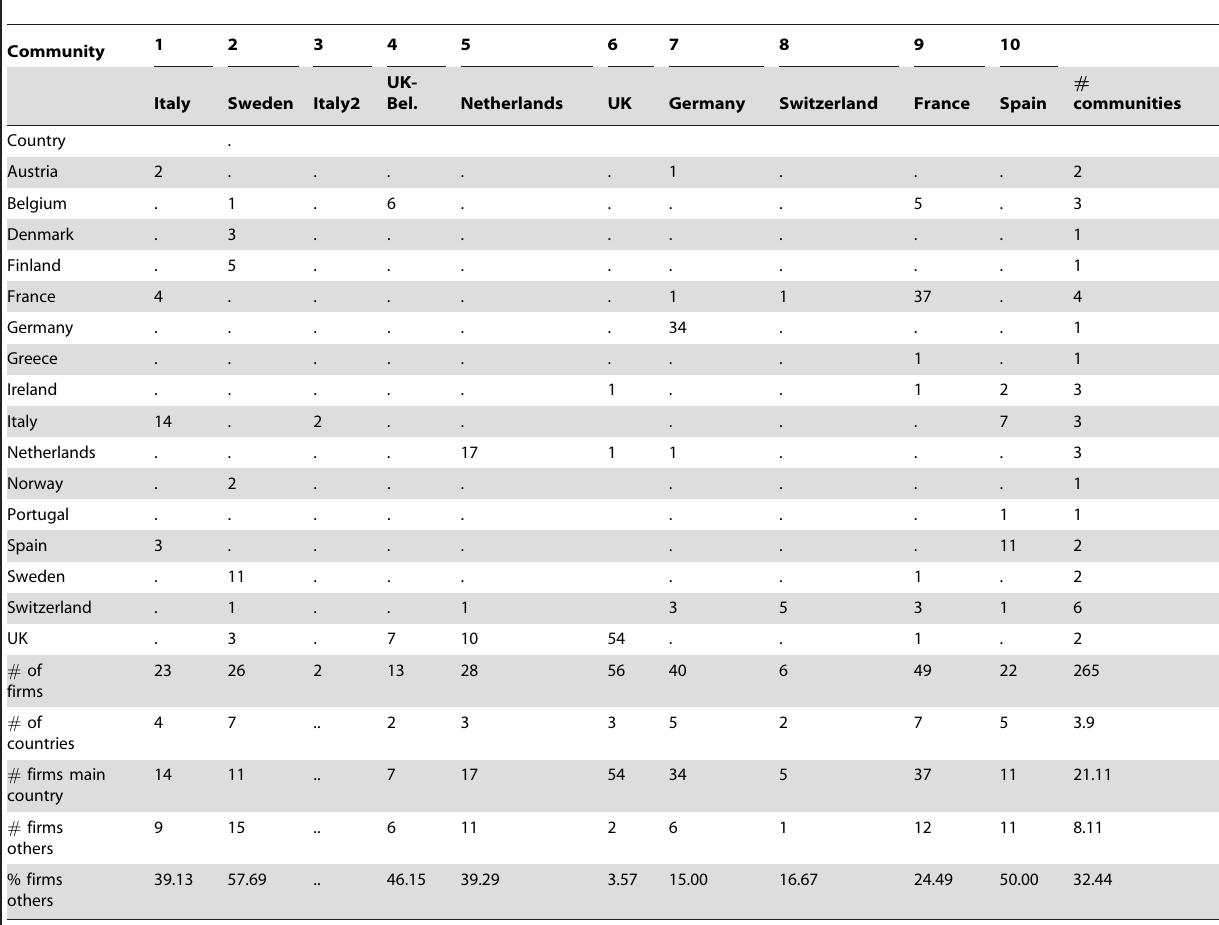
Table 4. Country distribution of the best-found subdivision into communities – Year 2005.